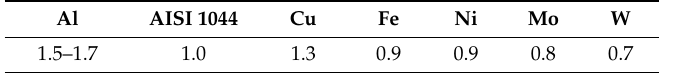
Table 3. The experimental values of the factor M estimated for different metals [14].